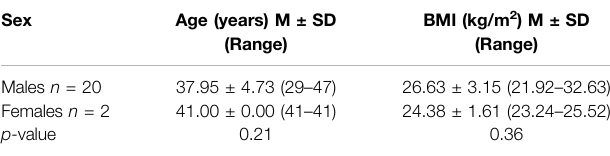
TABLE1| Studyparticipantdemographics.TherewerenoageorBMIdifferences between males and females ( p -values from Wilcoxon rank sum test).